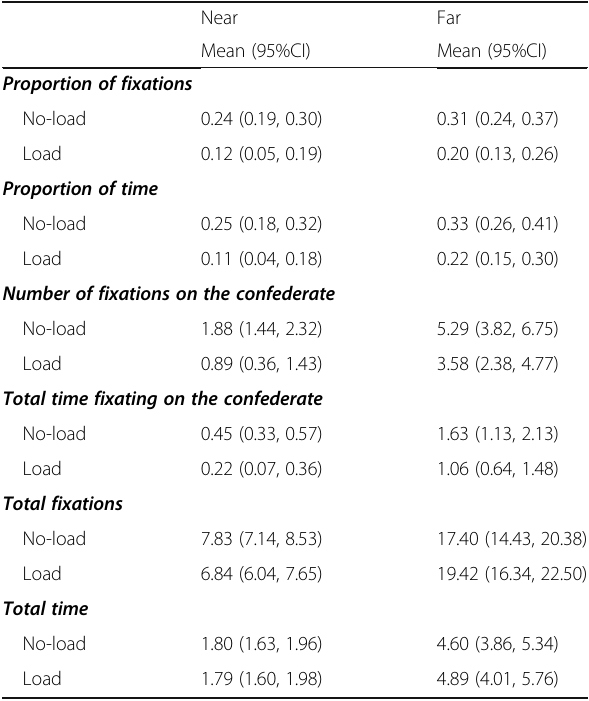
Table 2 Fixation behavior toward the confederate by Condition (no-load, load) and Proximity (near, far) in Experiment 1; time is reported in